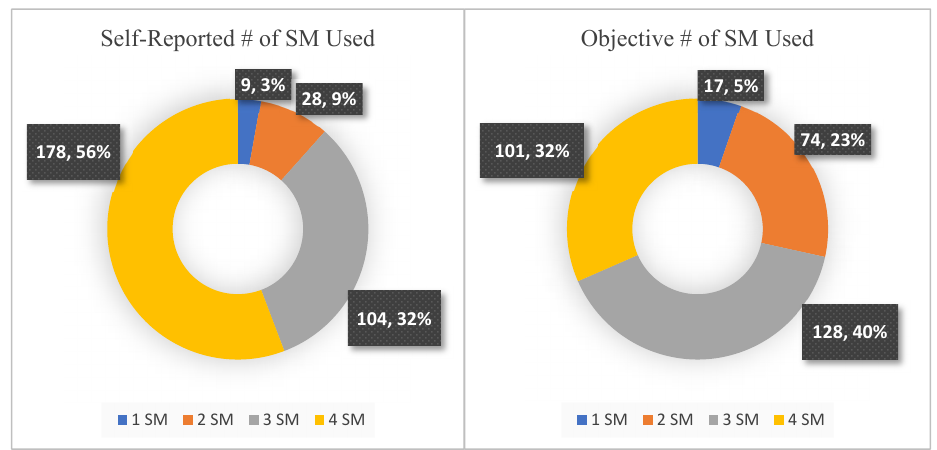
Figure 2. Number (#) of SM platforms “used” assessed via self-report and objectively logged time.